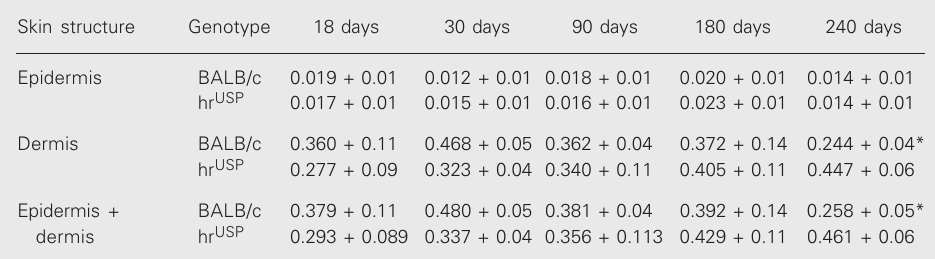
Table 3. Thickness of skin structures in male hr USP and BALB/c mice of different